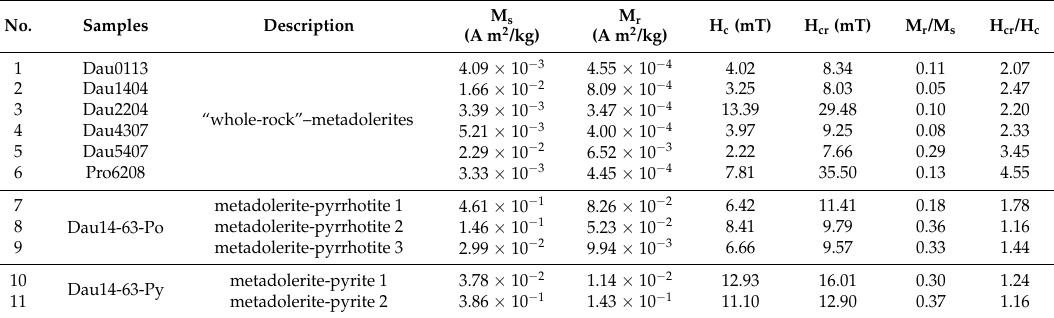
Table 1. Hysteresis parameters of investigated separates and “whole-rock” samples of metadolerites from SW Oscar II Land. M s —saturation magnetization; M rs —saturation remanence; H c